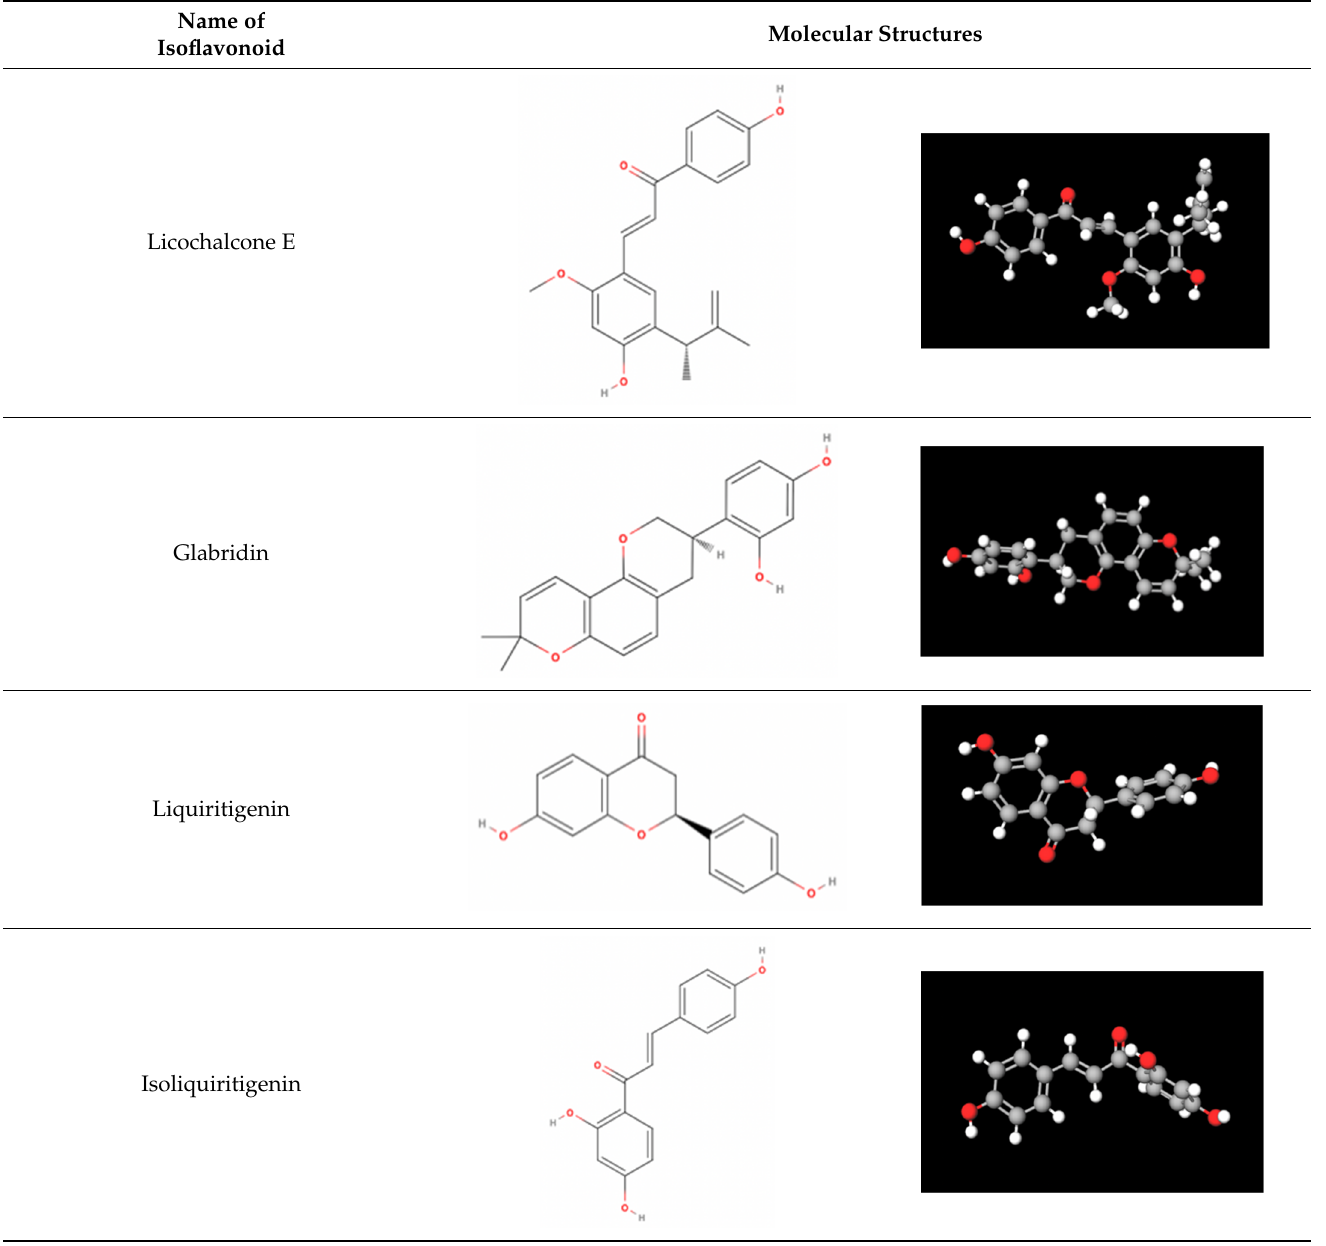
Table 3. The 2D and 3D structures of major isoflavonoids in licorice (derived from the MolView software). Name of Isoflavonoid